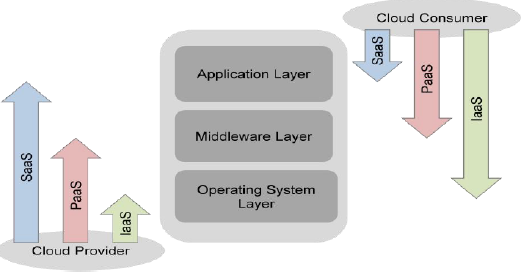
Figure 3. Scope of control between provider and consumer (source